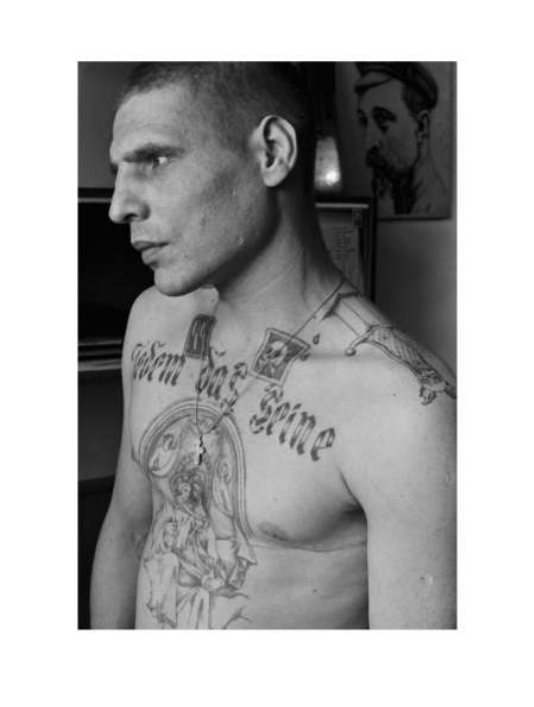
Figure 5: Danzig Baldaev. Print No.